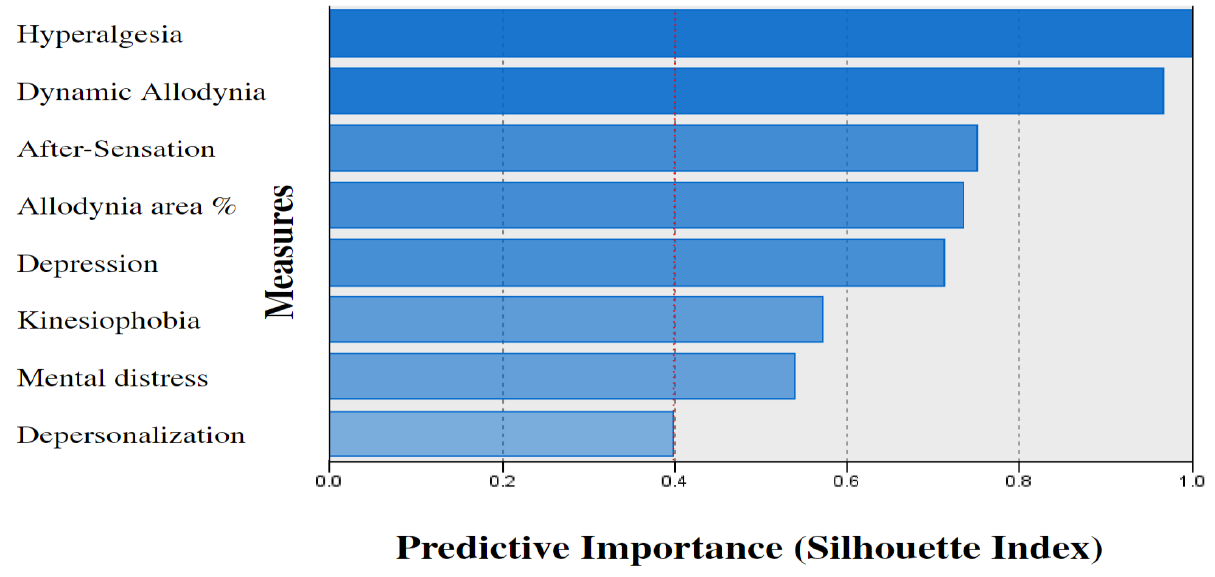
Figure 2. The measures’ predictive importance. Note: Two-step cluster analysis predictive importance measures. All measures are within the cutoff level of 0.4 silhouette index.